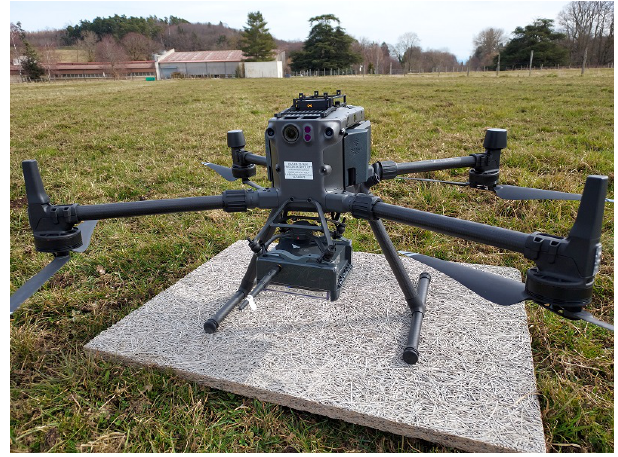
Figure 8. The UAV used for the experimentations (Matrice 300 RTK—DJI) with the collector node attached on the underside.